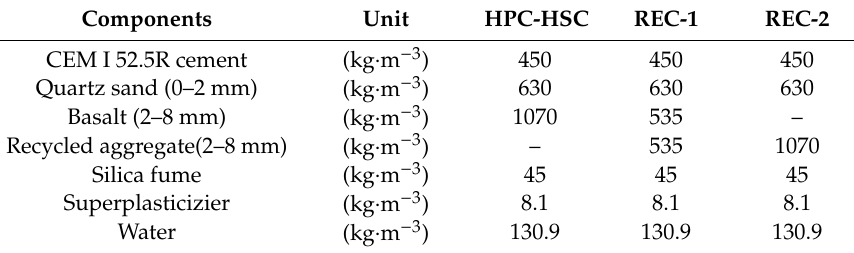
Table 3. Chemical composition of the natural quartz